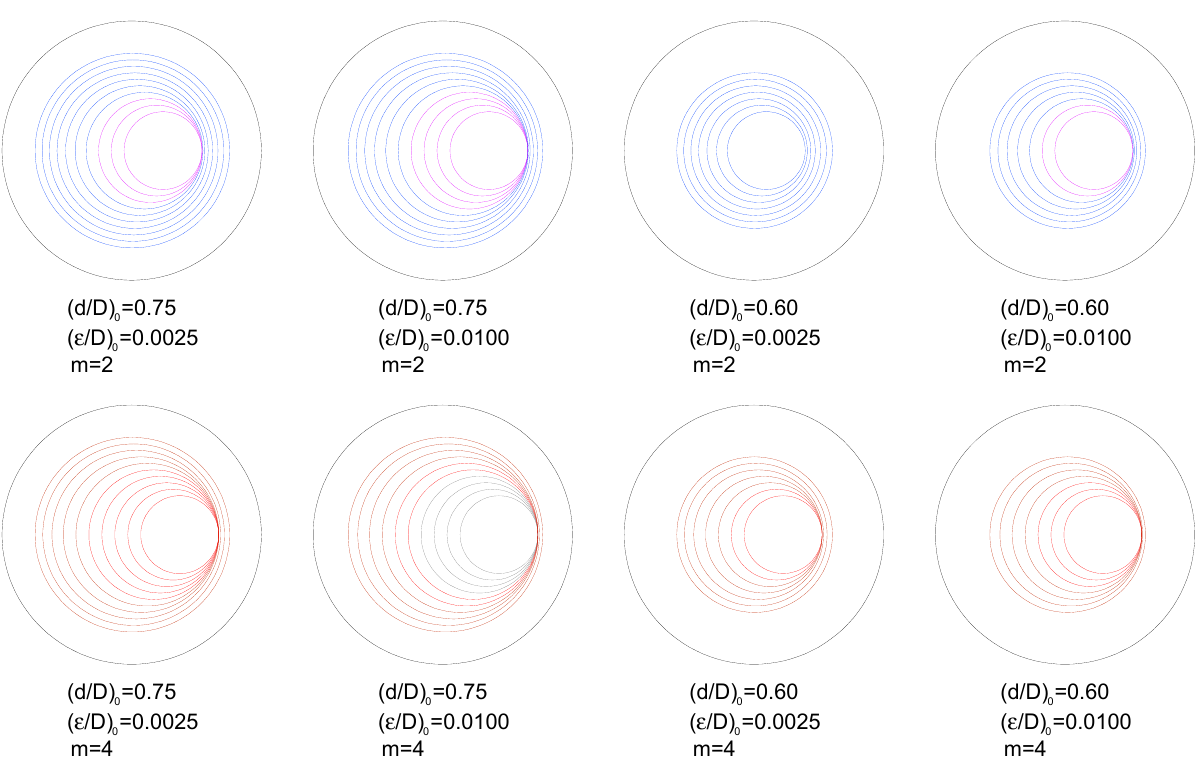
Figure 9. Crack fronts for remote tensile loading ; m = 2: no contact in blue, partial contact in pink, and full contact in grey; m = 4: no contact in brown, partial contact in red, and full contact in grey.